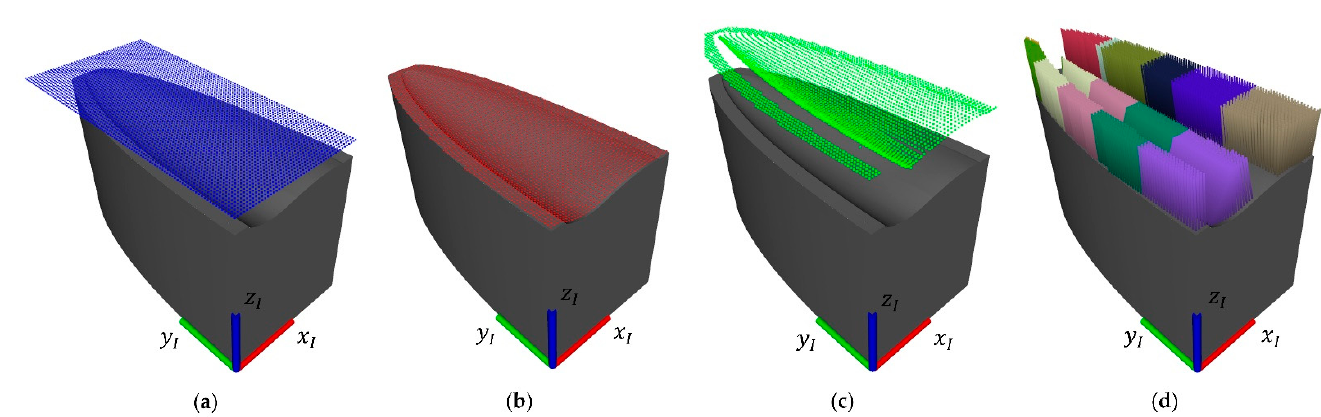
Figure 9. Process of workpiece segmentation. ( a ) Scanning grid; ( b ) projection onto surface; ( c ) reflection alongside surface normal; ( d ) clustering into local scan areas.